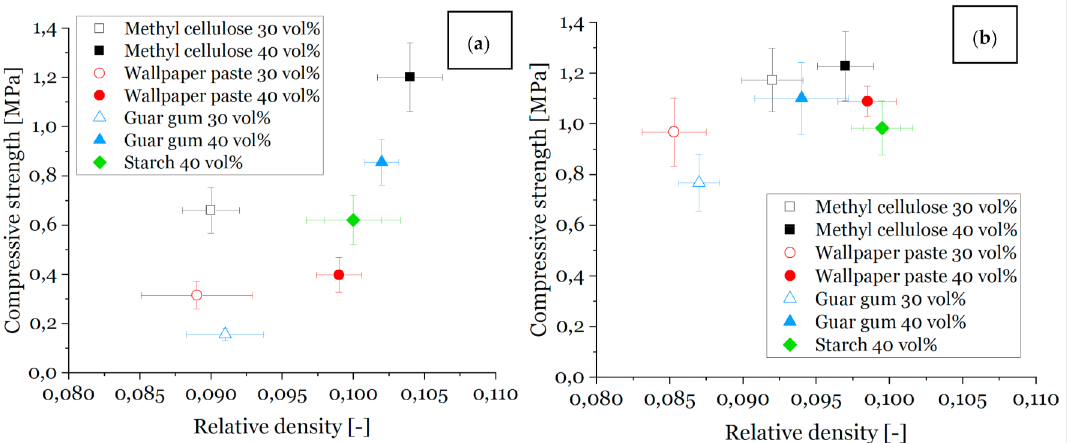
Figure 10. Compressive strength vs. relative density of all sample series and solid loads, sintered at 1650 ◦ C; ( a ): samples with freeze casting, ( b ): samples dried at room temperature.